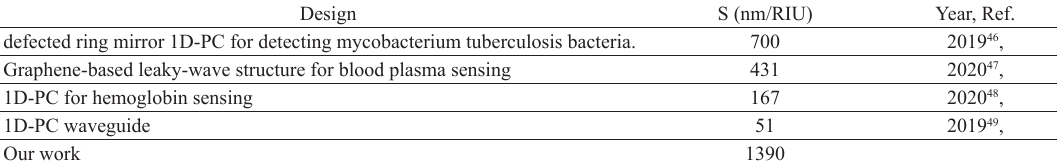
Table 3. Comparing the sensitivity of the proposed sensor with other biosensing designs. Design S (nm/RIU)